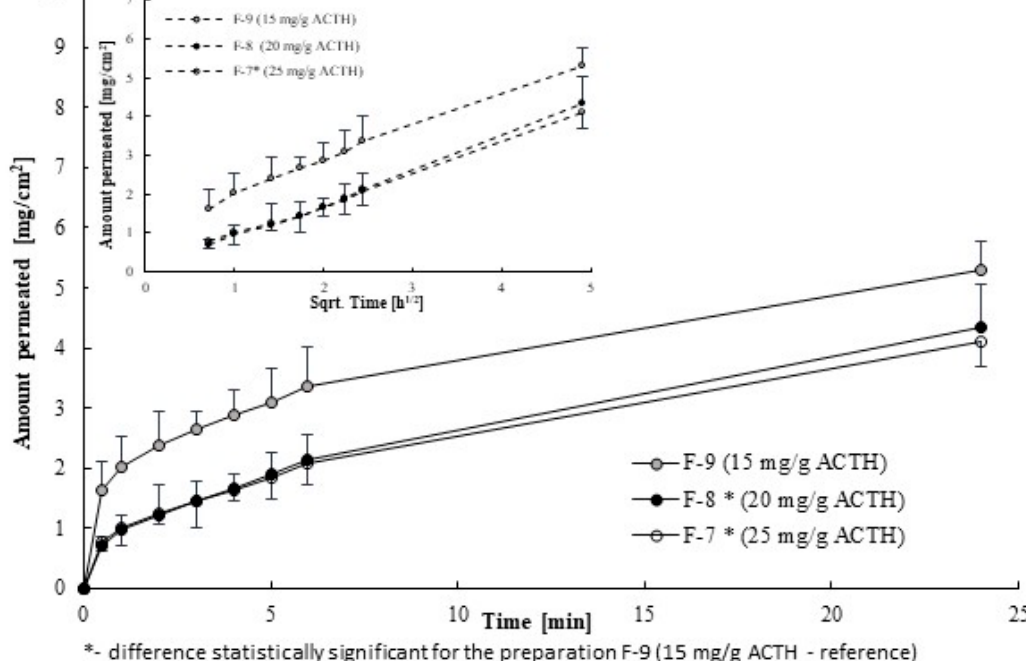
Figure 3. Kinetics of ACTH permeation through the porcine skin.